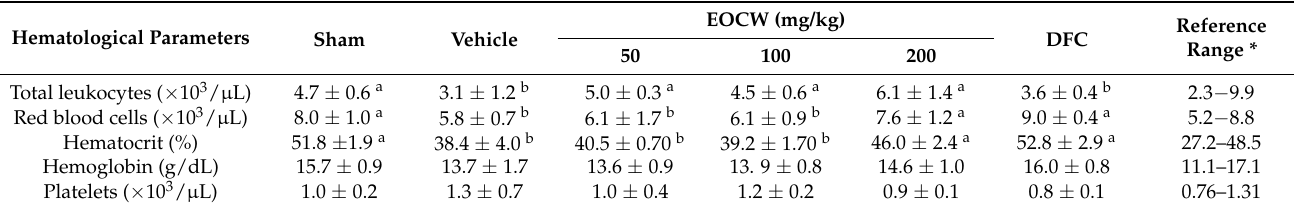
Table 5. Hematological parameters of the animals submitted to the